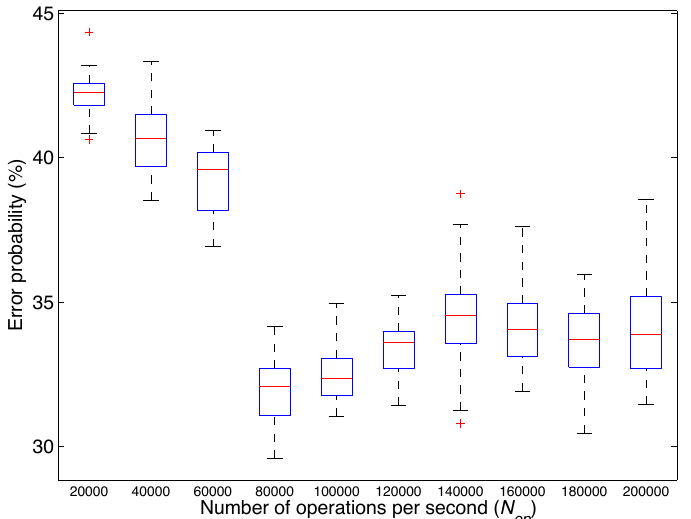
Figure 12. Box plot of the probability of error obtained by the classifiers for different values of the maximum number of operations per second ( N mental